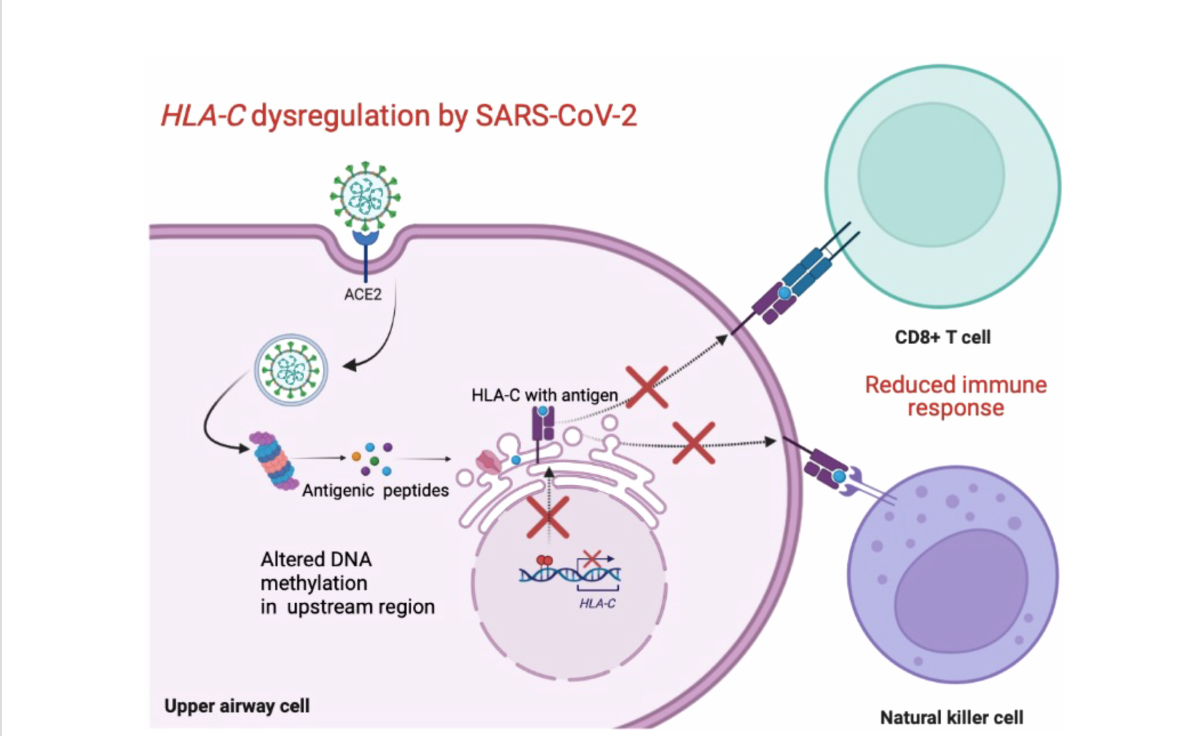
FIGURE 1 Schematic overview of the possible mechanism used by SARS-CoV-2 to downregulate HLA-C and evade the host ’ s immune response. Created with